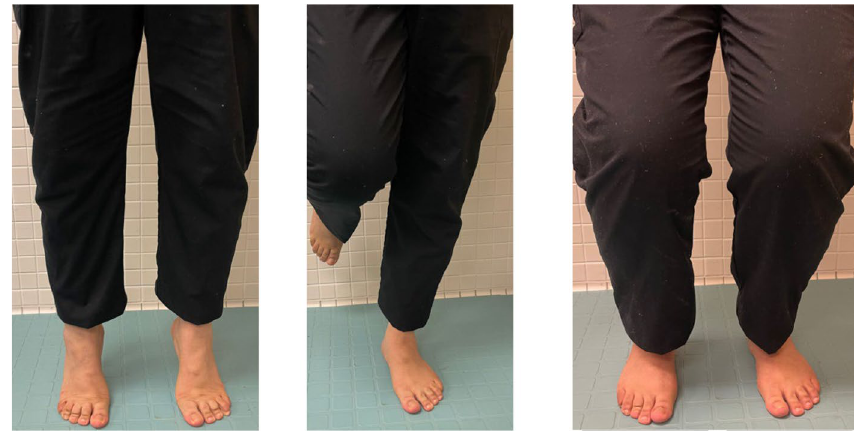
Fig. 3 Calf raises, single leg standing, lower limb squat